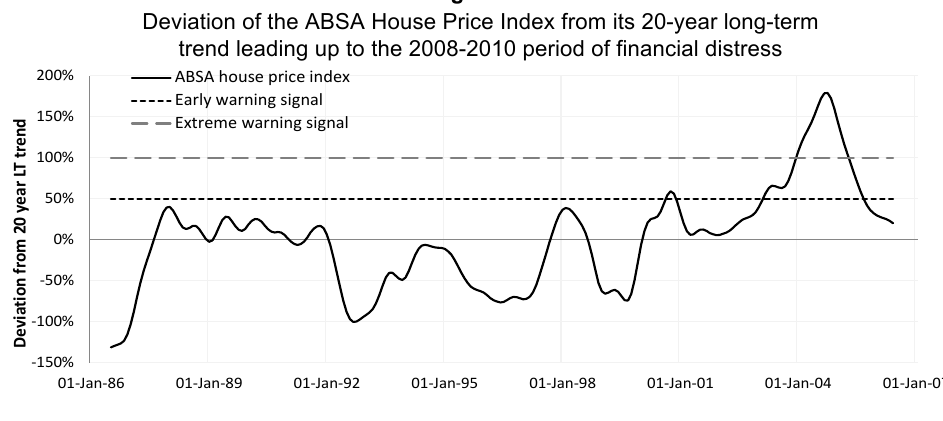
Deviation of the ABSA House Price Index from its 20-year long-term trend leading up to the 2008-2010 period of financial distress